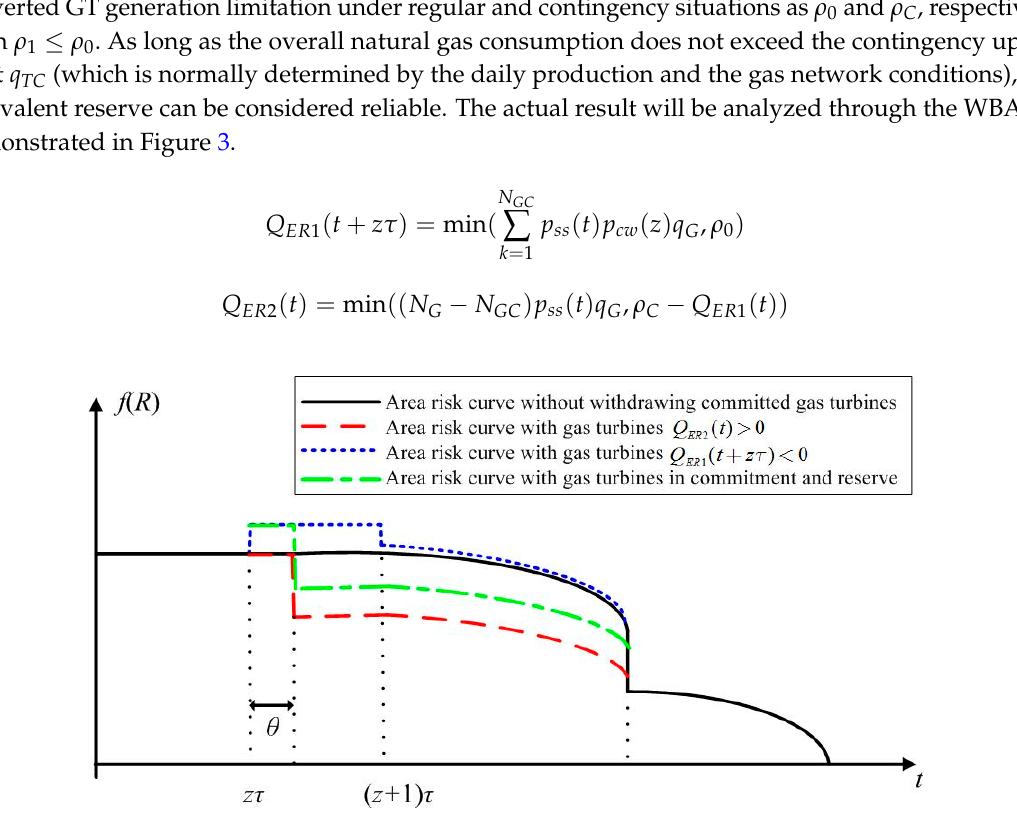
Figure 3. The area risk curves under the impacts of instantaneous output changes and available reserve of GT